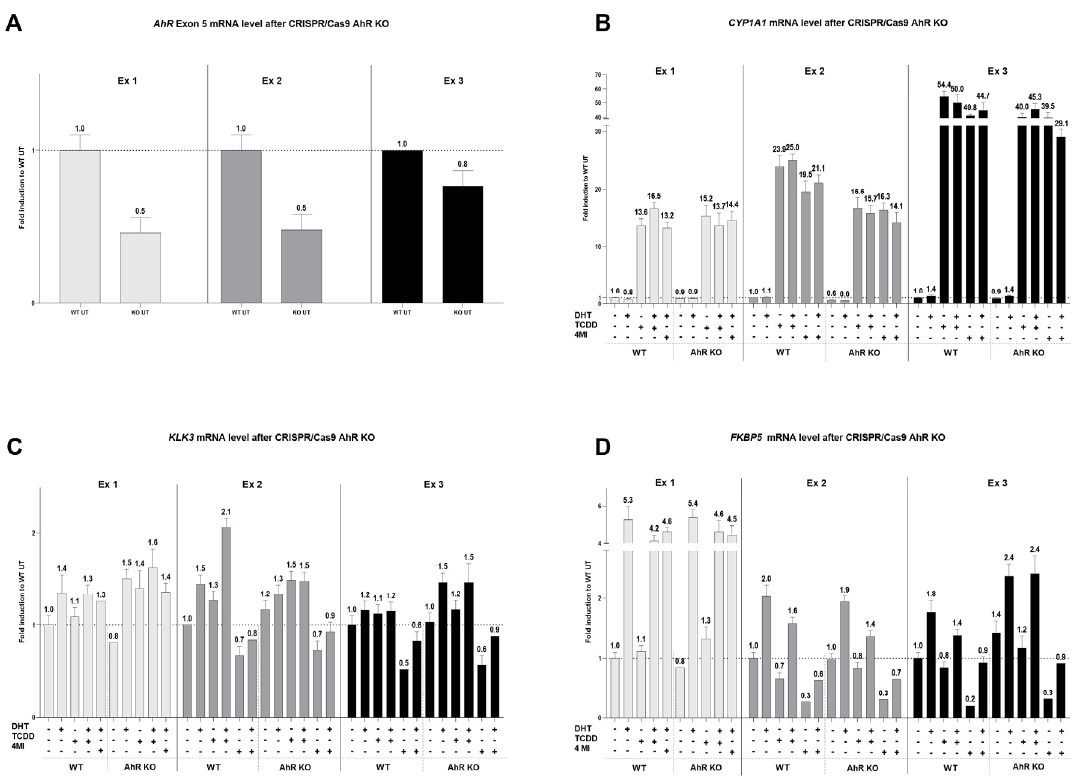
Figure 6. Expression of target genes after CRISPR/Cas9 AhR knockout. 22Rv1 cells were transiently transfected with the CRISPR/Cas9 AhR knockout plasmid or the Control CRISPR/Cas9 plasmid. After 48 h, transfected cells were treated with controls (UT; TCDD 10 nM with or without DHT 10 nM; DHT 10 nM) and 4MI 100 µM with or without DHT 10 nM. The induction of AhR ( A ), CYP1A1 ( B ), KLK3 ( C ), and FKBP5 ( D ) was determined by RT-qPCR. The data obtained were normalized per the housekeeping gene GAPDH . The results are expressed as fold induction in wild-type UT. In total, three independent experiments were analyzed.